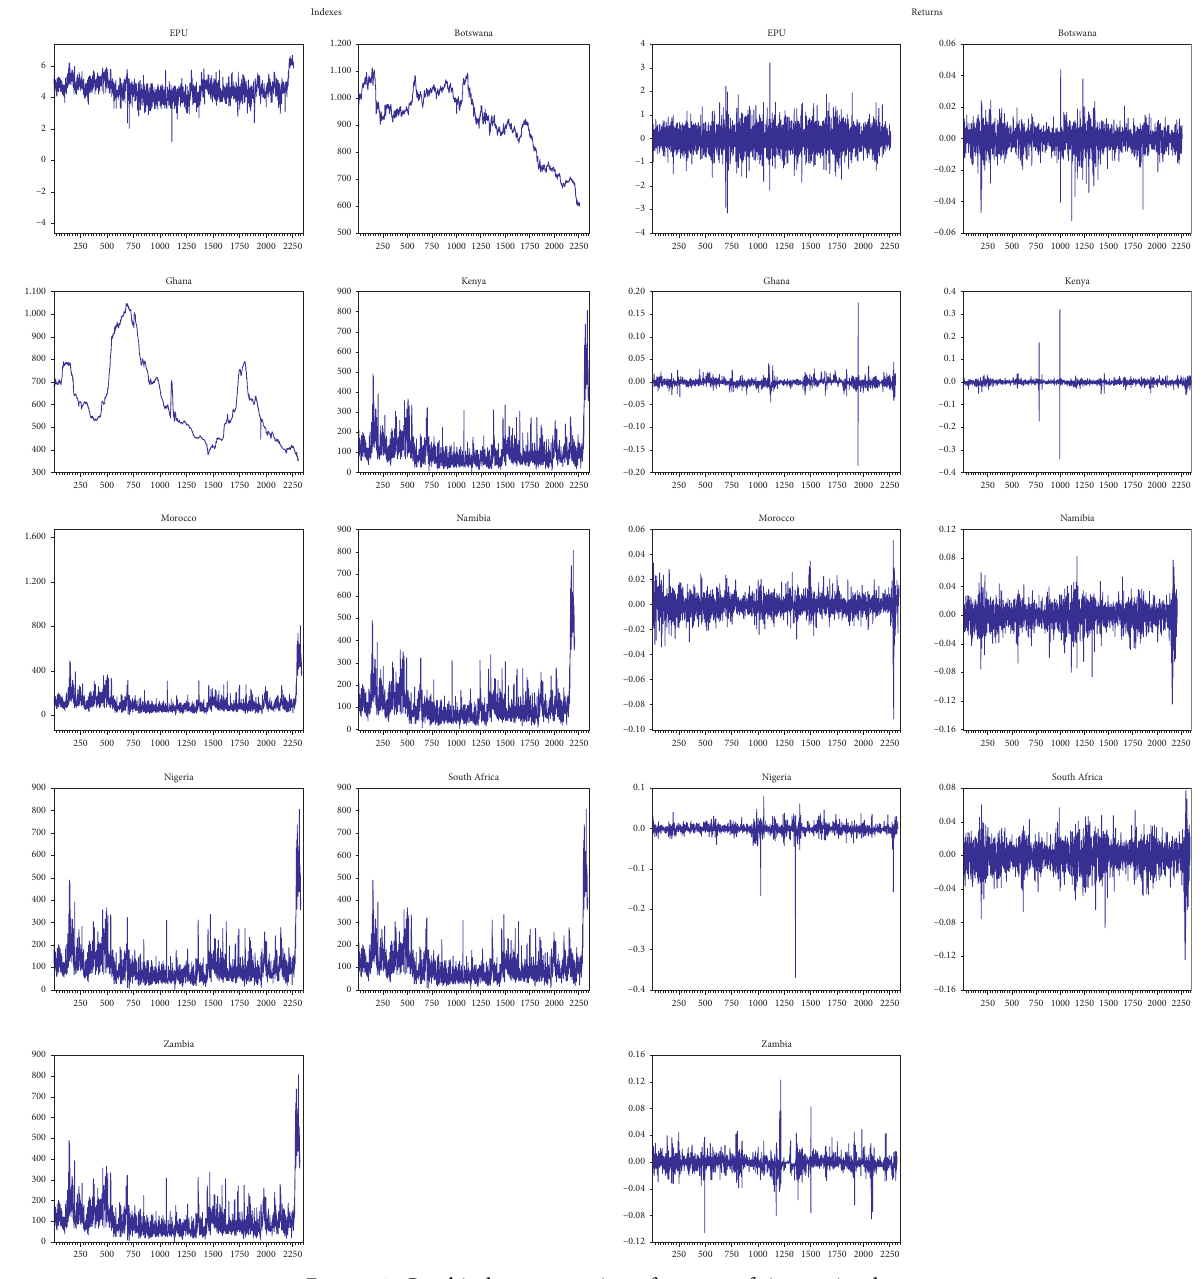
Figure 1: Graphical representation of returns of time series data. Table 1: Descriptive statistics of EPU and